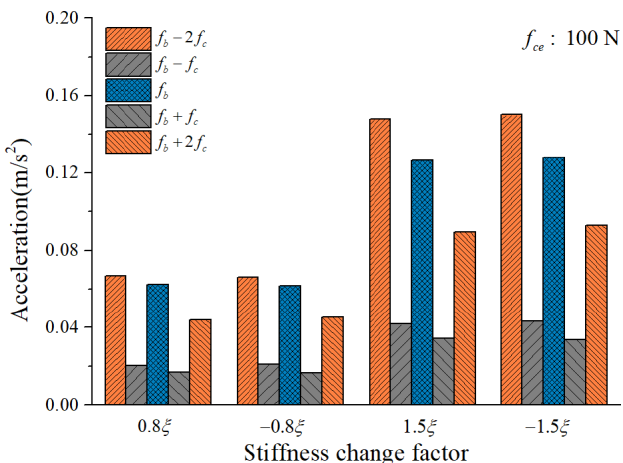
Figure 14. Envelope spectrum peak value at sideband modulation family.